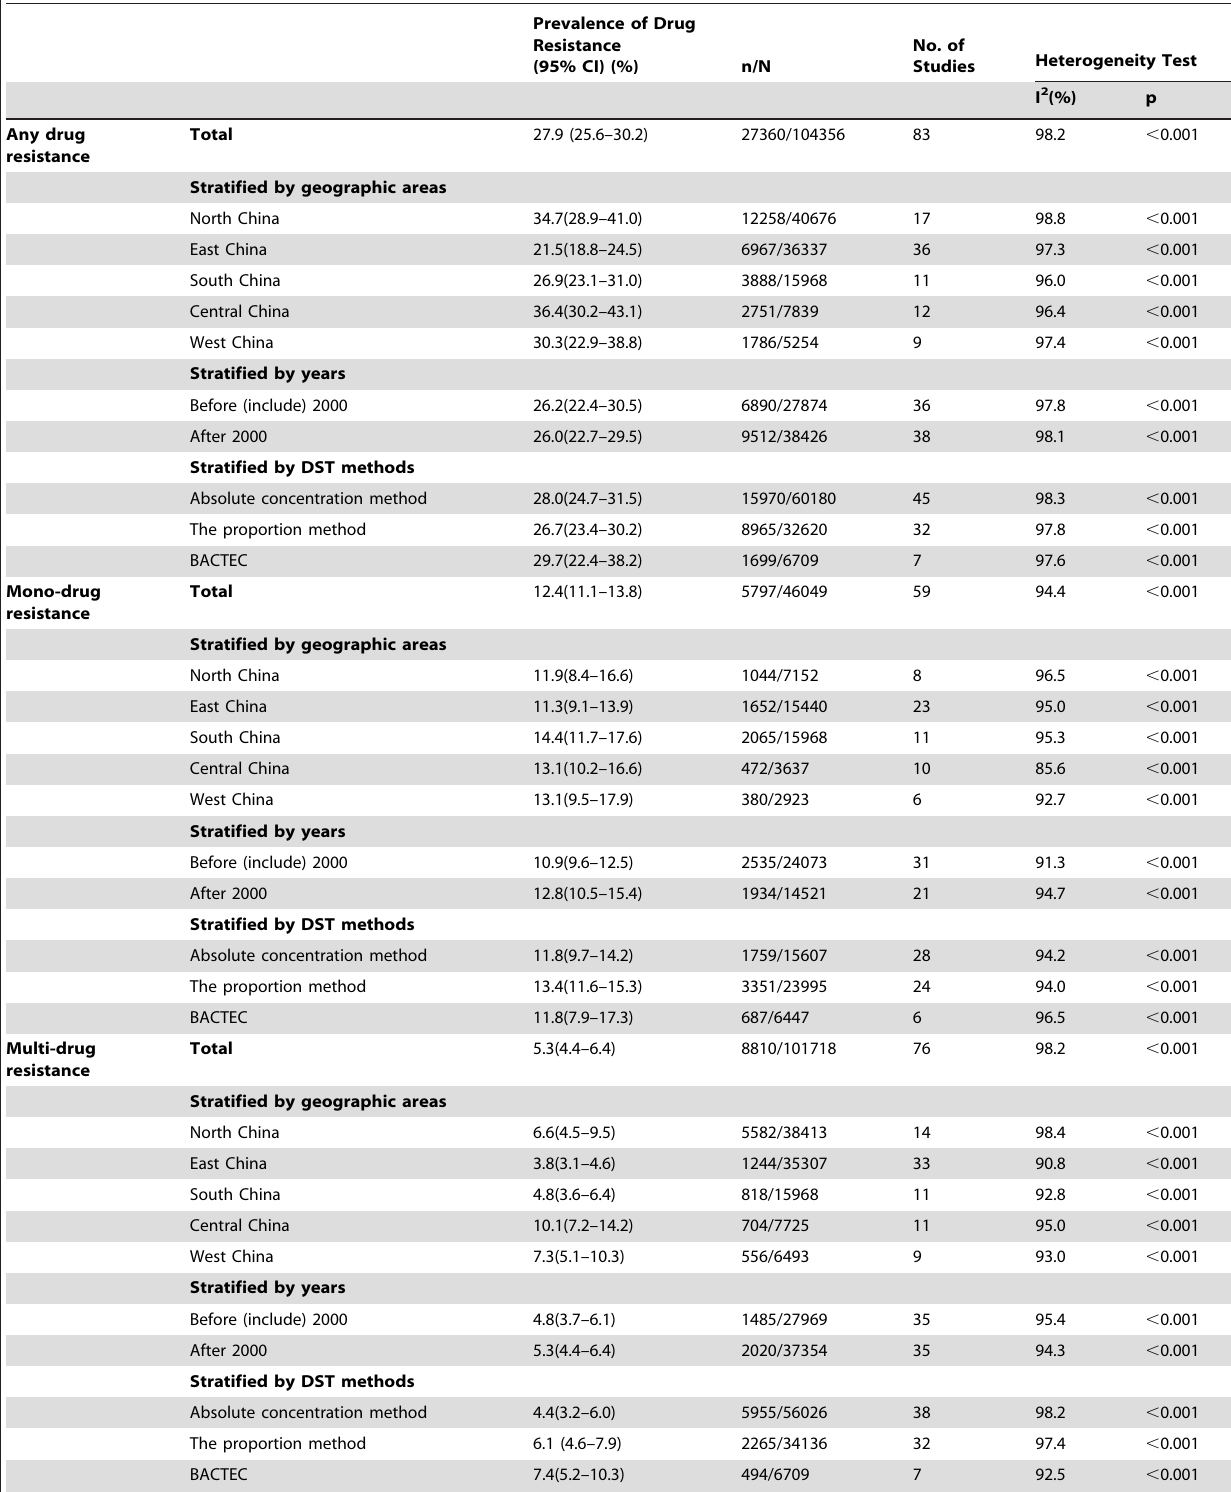
Table 1. Status of drug-resistant tuberculosis among new cases in China.